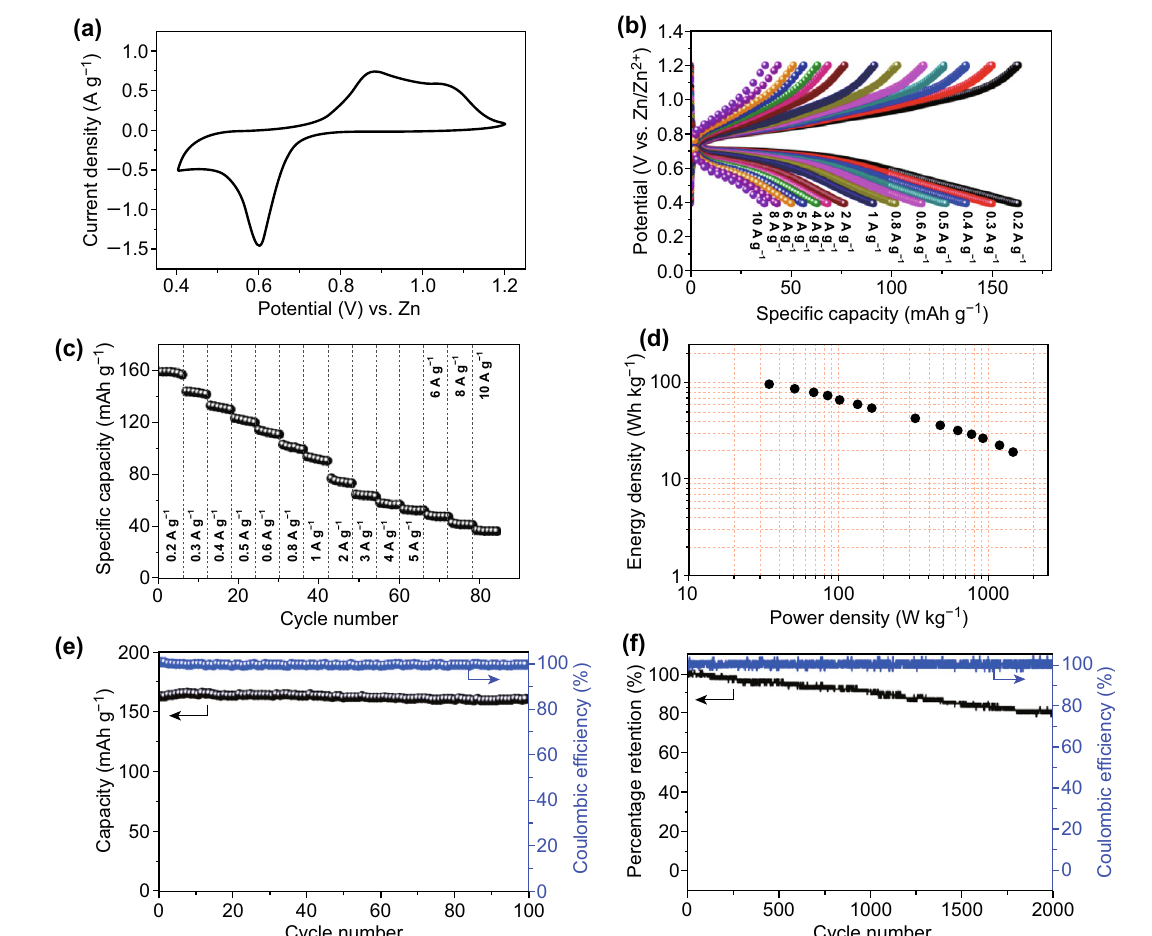
Fig. 2 a CV curve at 0.5 mV s −1 . b The charge/discharge curves. c Rate performance of Zn/Bi 2 S 3 cell at current densities from 0.2 to 10 A g −1 . d Ragone plot. e , f The long‑term cycling performance at current density of 0.2 A g −1 and 1 A g